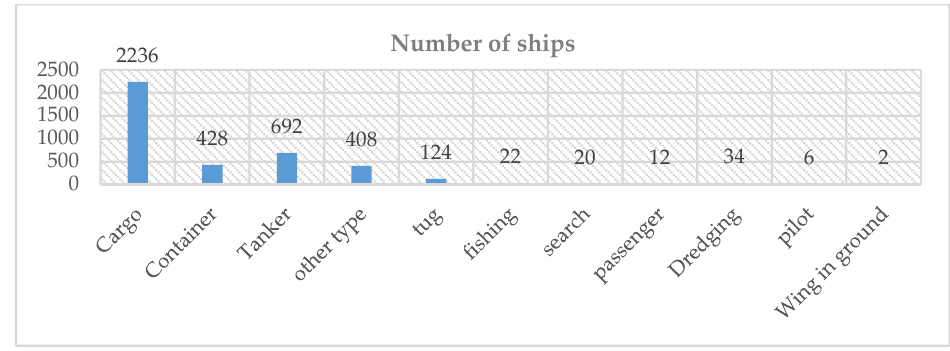
Figure 2. The statistical results of the types of ships in the GRD mode of the